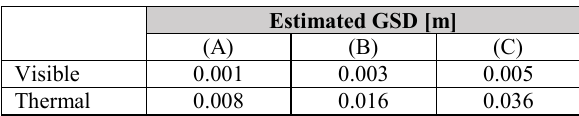
Table 2 . (A) Molini Allioni chapel, (B) Gobetti, (C) Morano, average shooting distance.